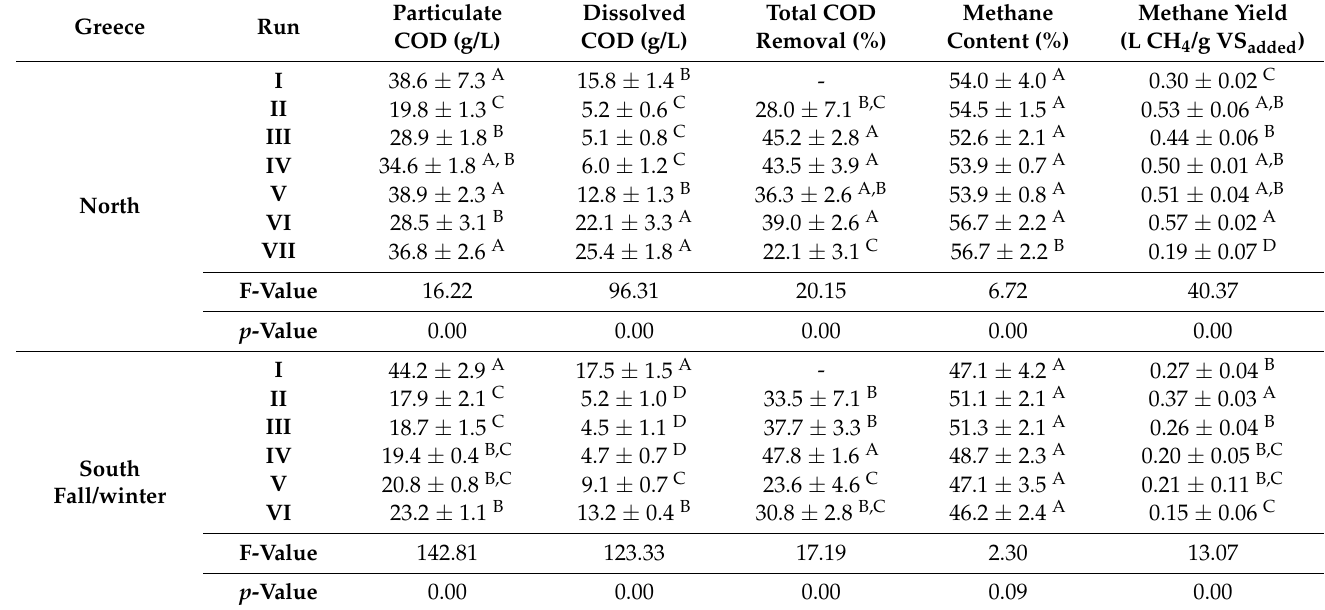
Table 2. Average values and standard deviation for the particulate and dissolved COD concentration of the effluent, the percentages of total COD removal and methane content, as well as for the methane yield, regarding both the Northern and Southern Greece scenarios. Statistical analysis ( n = 4, during steady state) and Tukey’s post hoc test were carried out for pairwise comparison (the same letter (A, B, C, D) indicates statistically insignificant differences ( p > 0.05) among the values of each